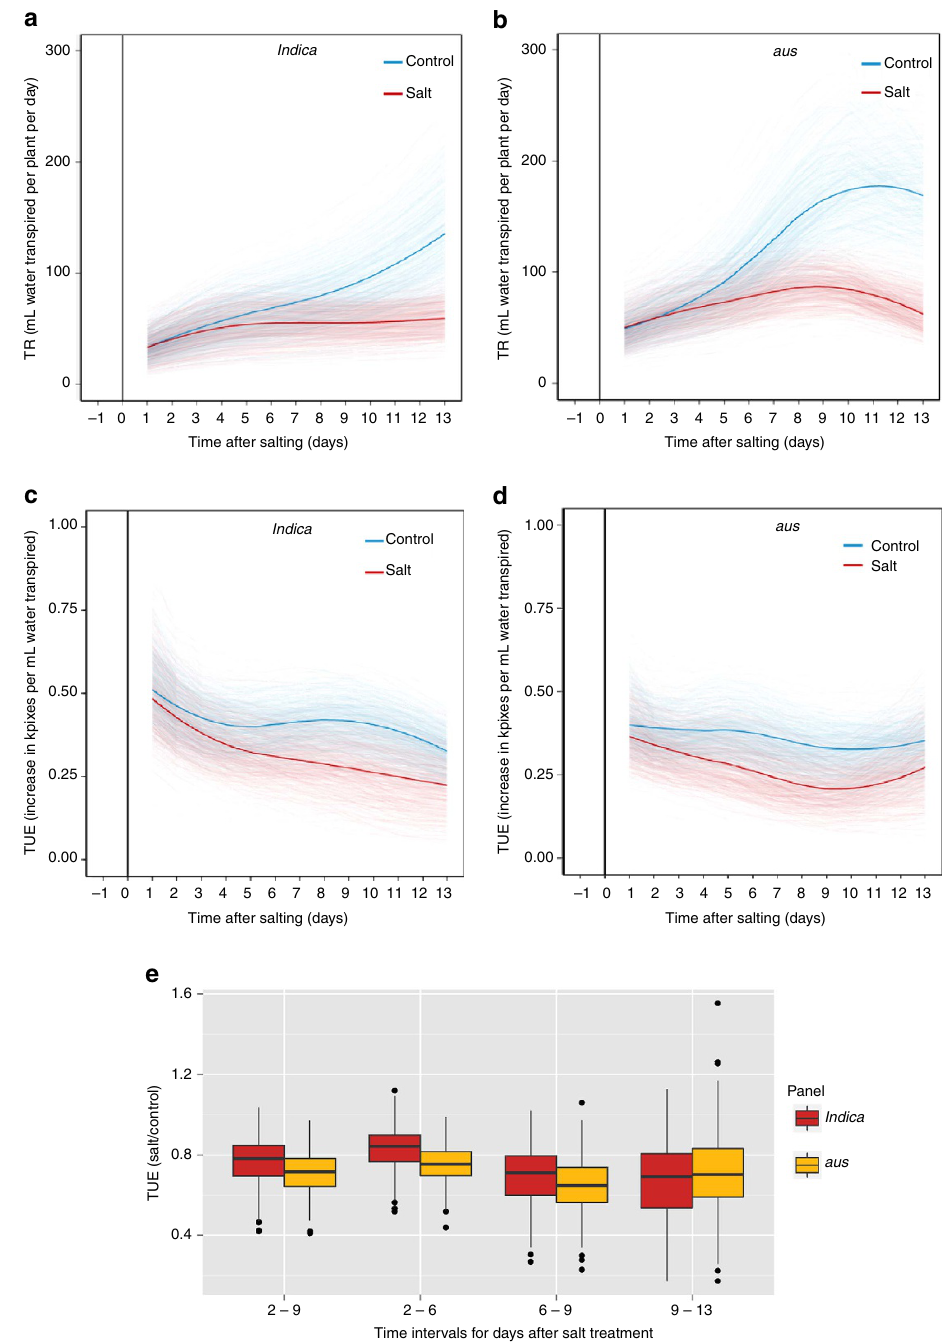
Figure 2 | Transpiration of salinity-induced responses comparing indica and aus. Spline curve fits of transpiration rate (TR) through time for individual ( a ) indica and ( b ) aus plants and transpiration use efficiency (TUE) through time for individual ( c ) indica and ( d ) aus plants. The solid blue lines represent the grand average spline in control conditions and the solid red lines represent the same in saline conditions. ( e ) Box plots of the TUE salinity tolerance index (salt/control), comparing indica ( n ¼ 528; partially replicated; median ¼ 0.78, 0.84, 0.71 and 0.69 for intervals: 2–9, 2–6, 6–9 and 9–13, respectively) and aus ( n ¼ 226; fully replicated; median ¼ 0.71, 0.75, 0.64 and 0.70 for intervals: 2–9, 2–6, 6–9 and 9–13 days after salting, aus panel (16.7% versus 24.4% for interval 2–6 days after treatment; Supplementary Table 1), and TUE was positively